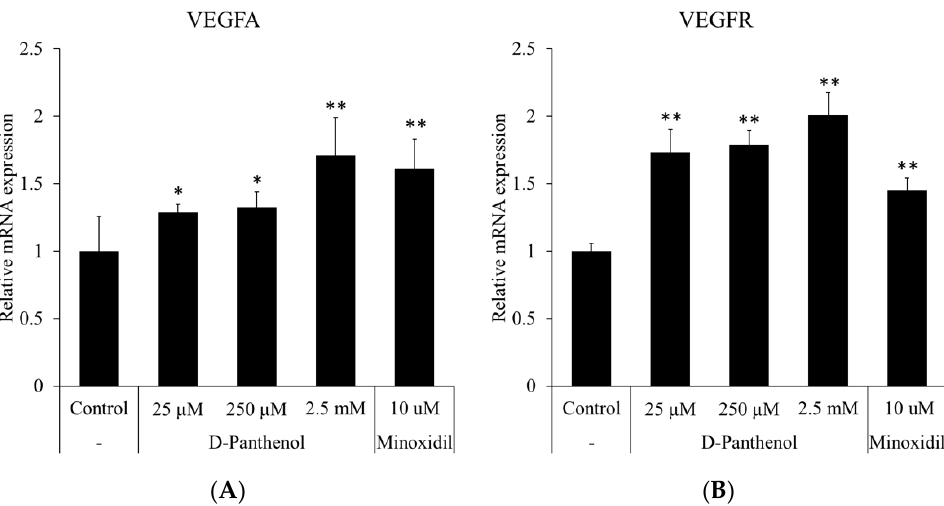
Figure 7. The mRNA expression levels of VEGF and VEGFR were up-regulated by D-panthenol treatment in cultured hORSCs. The mRNA expression of ( A ) VEGFA and ( B ) VEGFR (KDR) was evaluated by RT-PCR after 24 h treatment of D-panthenol. * p < 0.05, ** p < 0.01 versus control group. Data are expressed as mean ± SD.